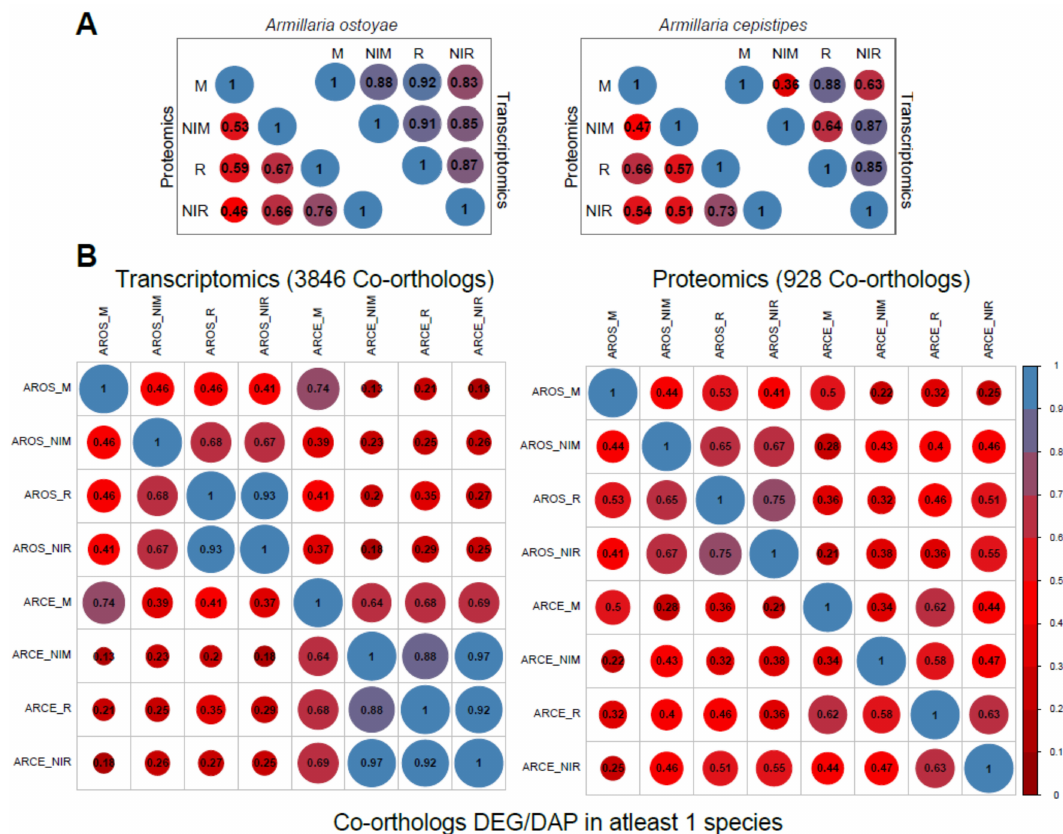
Figure 3. Global transcriptome/proteome similarity between A. ostoyae and A. cepistipes . ( A ) Correlation between the 4 tissue types for proteomics and transcriptomics data in A. ostoyae (left) and A. cepistipes (right). ( B ) Correlation between co- orthologs which were significantly differentially expressed/abundant in at least one of the species (for all co-orthologs, see Supplementary Figure S5), showing correlation between samples across the two species. Blue represents higher correlation and red represents lower. Size of the circle is directly proportional to higher correlation. Pairwise mean Pearson correlation coefficients are given as numbers in the